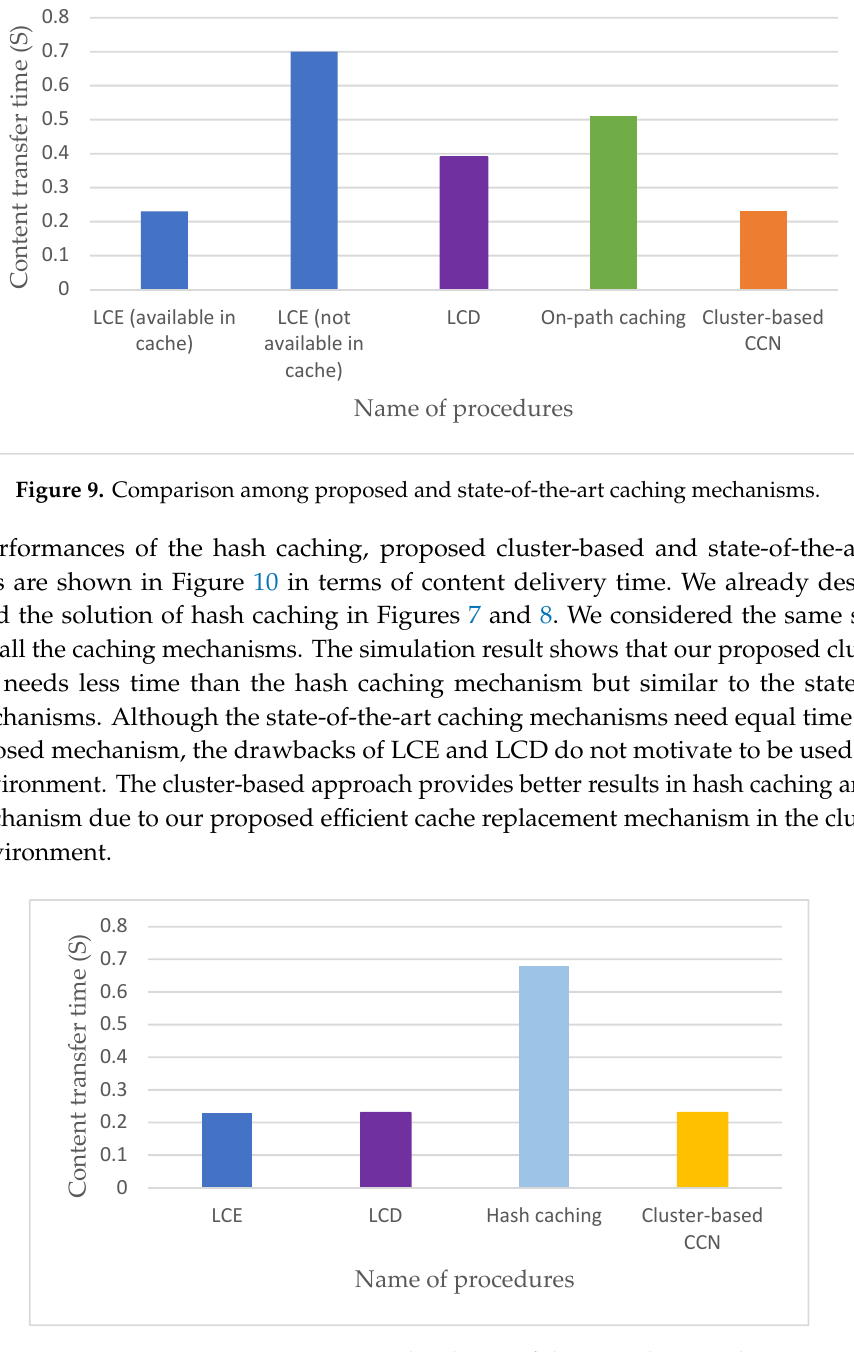
Figure 10. Comparison among proposed and state-of-the-art caching mechanisms.